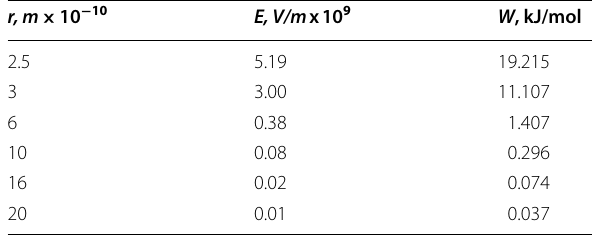
Table 2 The parameters of electric fields created by SACs of cellulose, depending on the distance